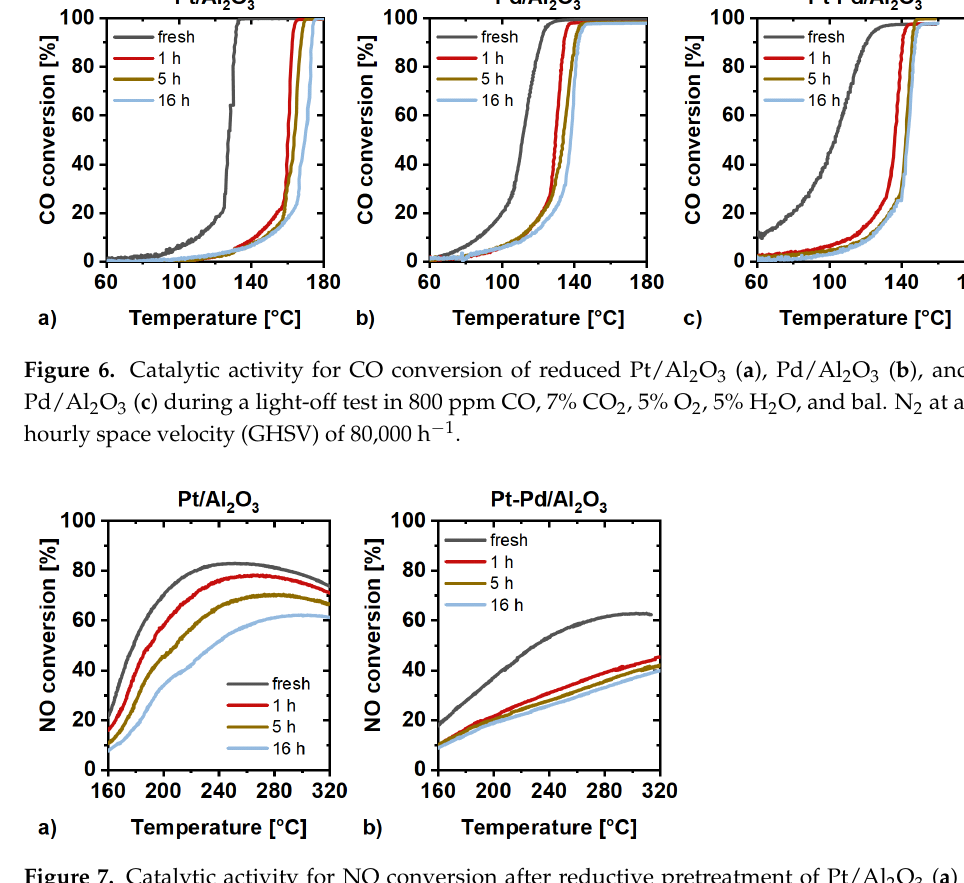
Figure 7. Catalytic activity for NO conversion after reductive pretreatment of Pt/Al 2 O 3 ( a ) and Pt-Pd/Al 2 O 3 ( b ) during a light-off test in 800 ppm NO, 7% CO 2 , 5% O 2 , 5% H 2 O, and bal. N 2 at a GHSV of 40 000 h −1 .